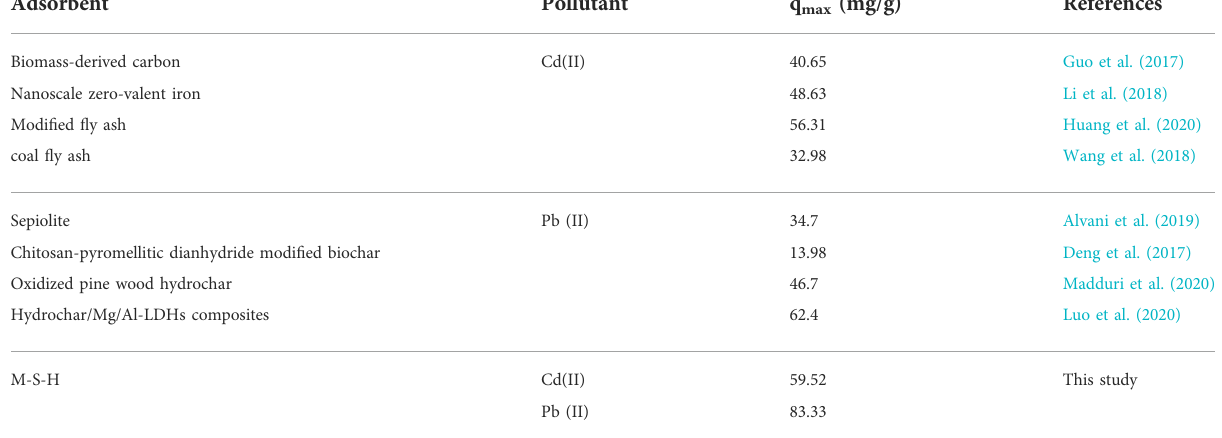
TABLE 4 Thermodynamic parameters for Cd(II) and Pb(II) adsorption. Adsorbate